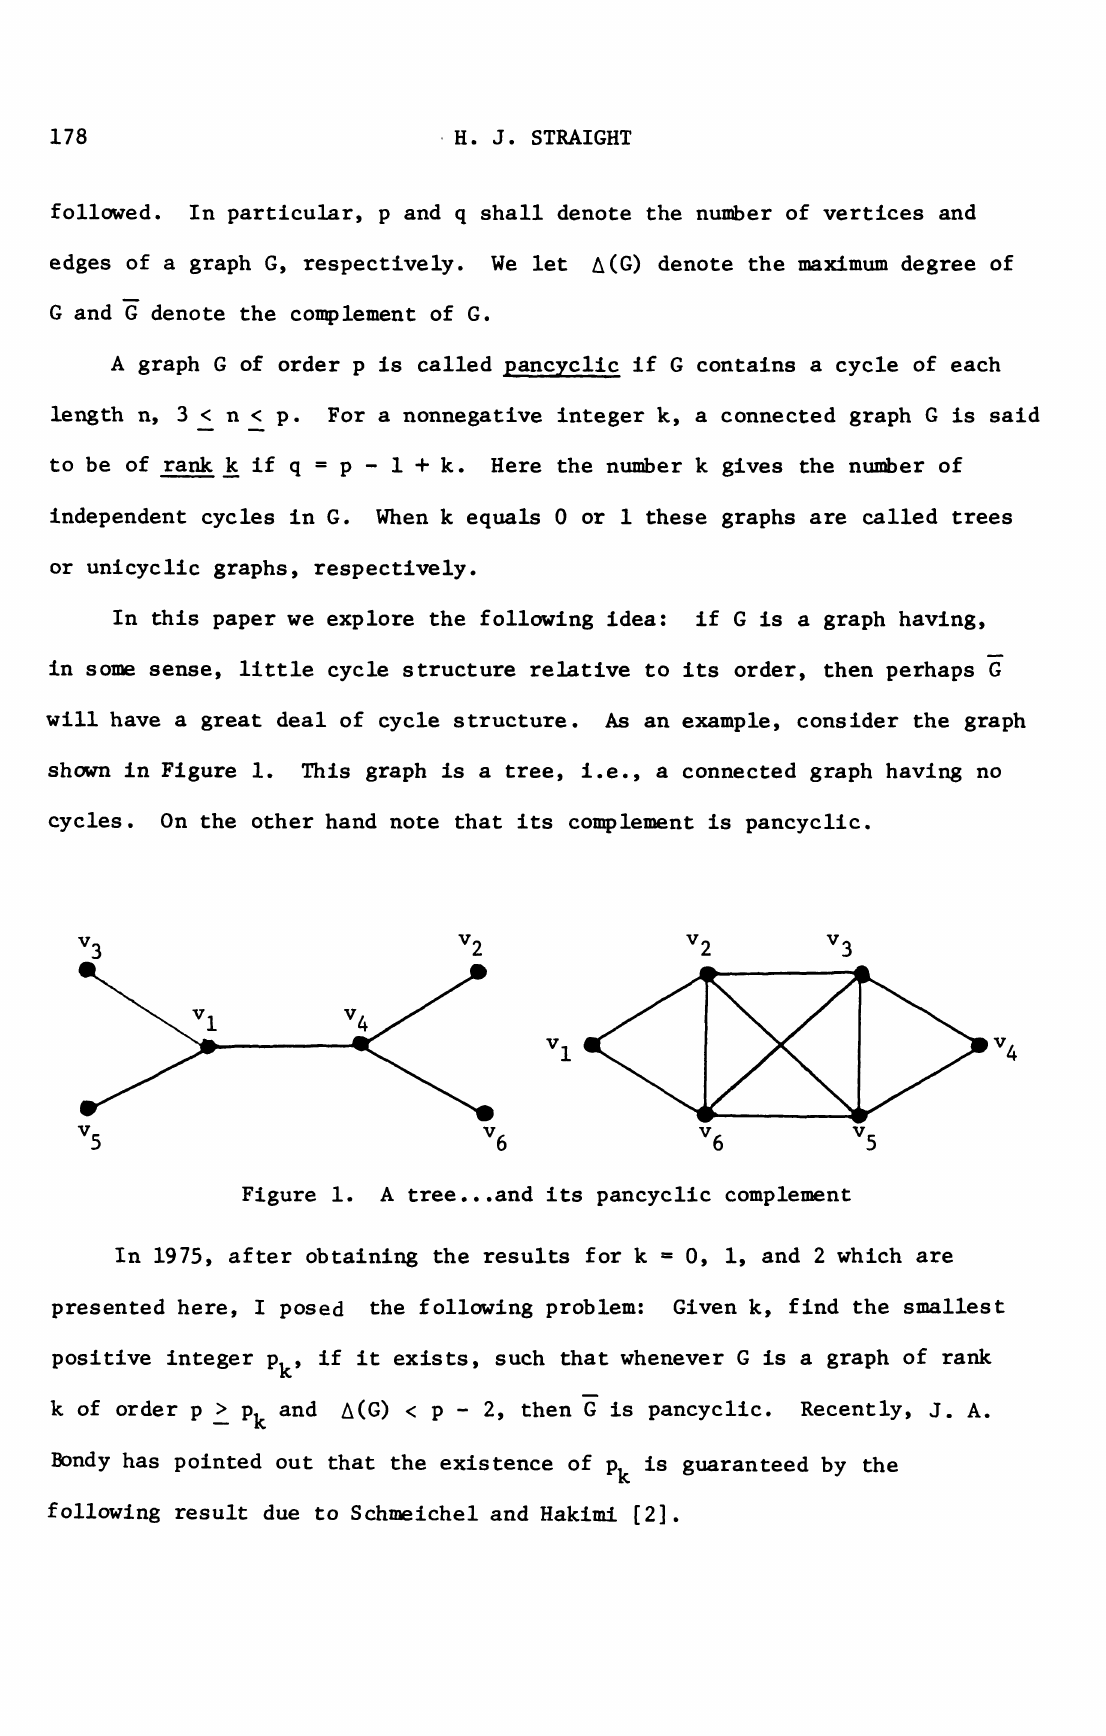
Figure i. A tree...and its pancyclic